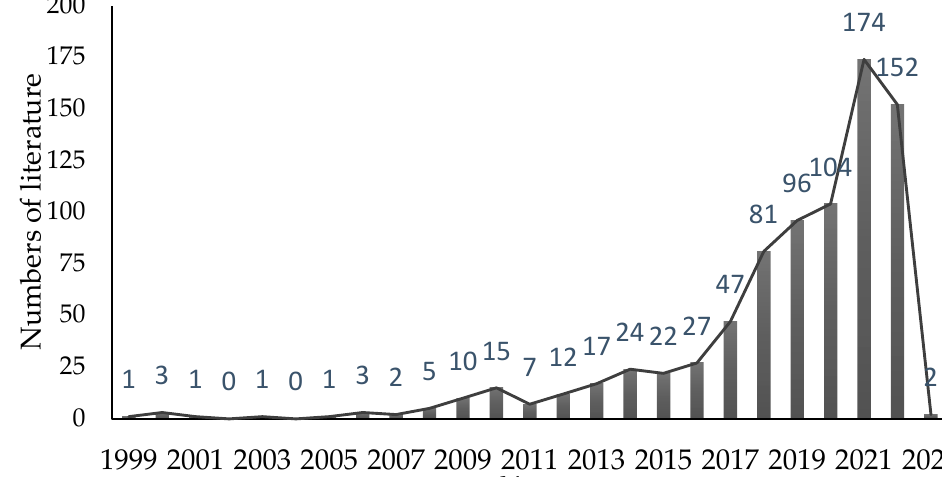
Figure 2. The trend of the number of annual publications for the study of green space and senior mental health.